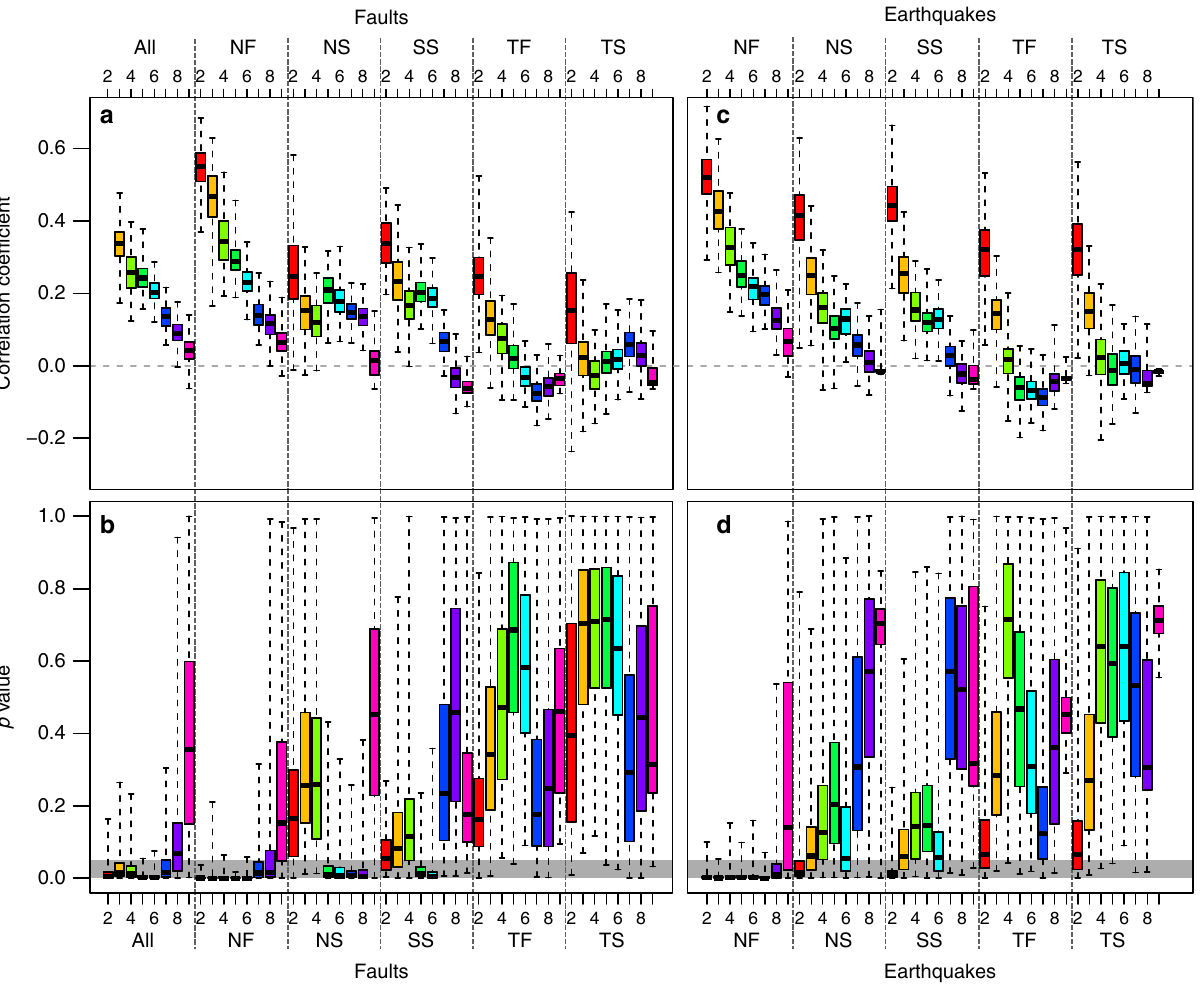
Fig. 3 Correlation between gas discharges and tectonic regimes. Box plots of calculated p values and Spearman ’ s rank correlation coef fi cients between gas discharges and a , b faults lengths of different slip types and c , d different tectonic stress regimes. Upper and lower whiskers are maximum and minimum values. Horizontal gray stripe in ( b , d ) shows the 95% con fi dence interval (the null hypothesis of no correlation is rejected if p value < 0.05). Box colors denote the eight hexagonal grids used for the calculations, from the greatest (red, resolution 2) to the smallest (pink, resolution 9) hexagonal